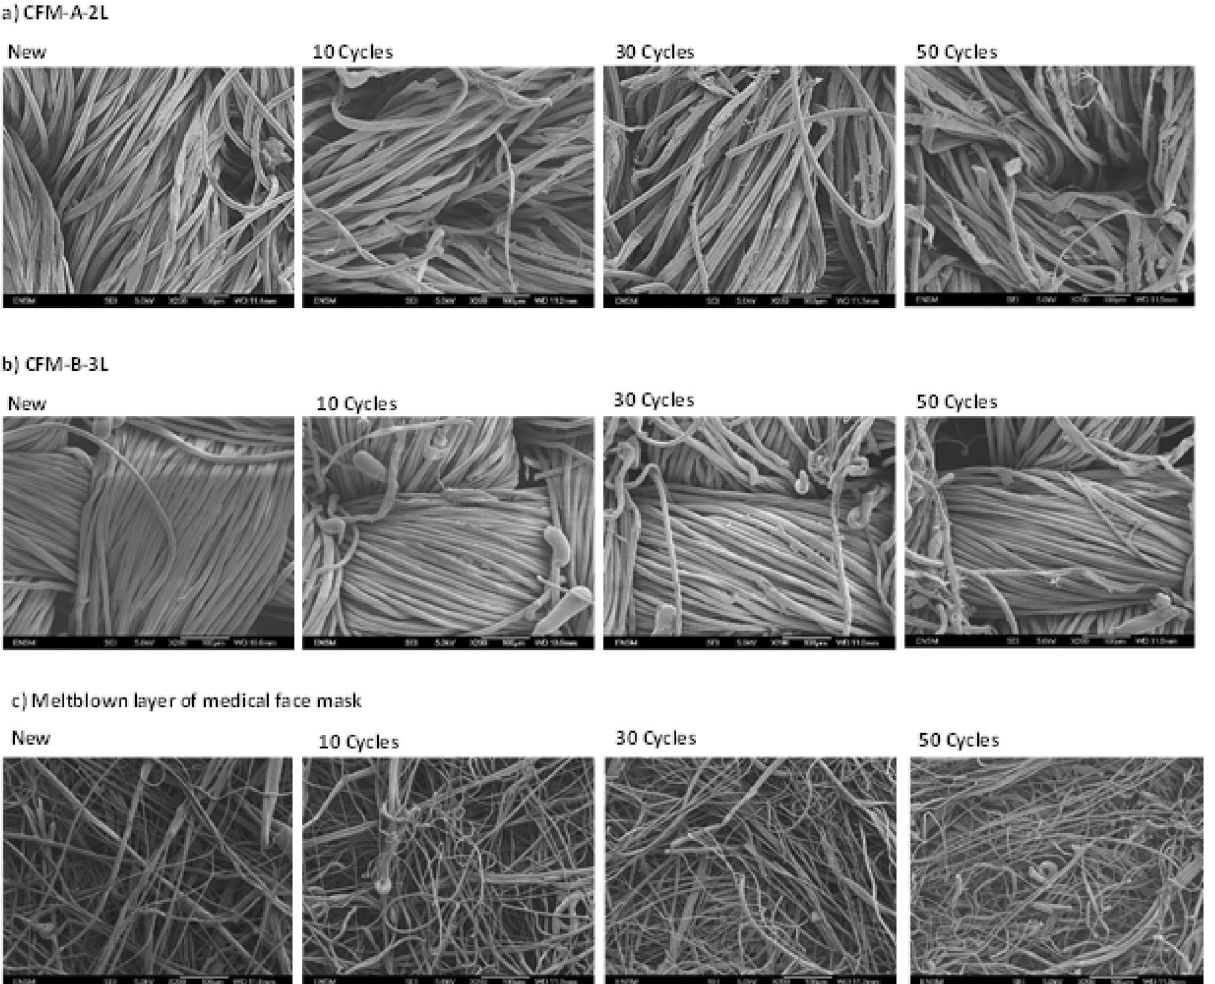
Figure 5. SEM images (200X magnification and scale bar corresponds to 100 μm) of : ( a ) CFM-A-2L, ( b ) CFM- B-3L, ( c ) meltblown layer of the medical face mask; for the new and washed masks subjected to varying number of wash cycles.